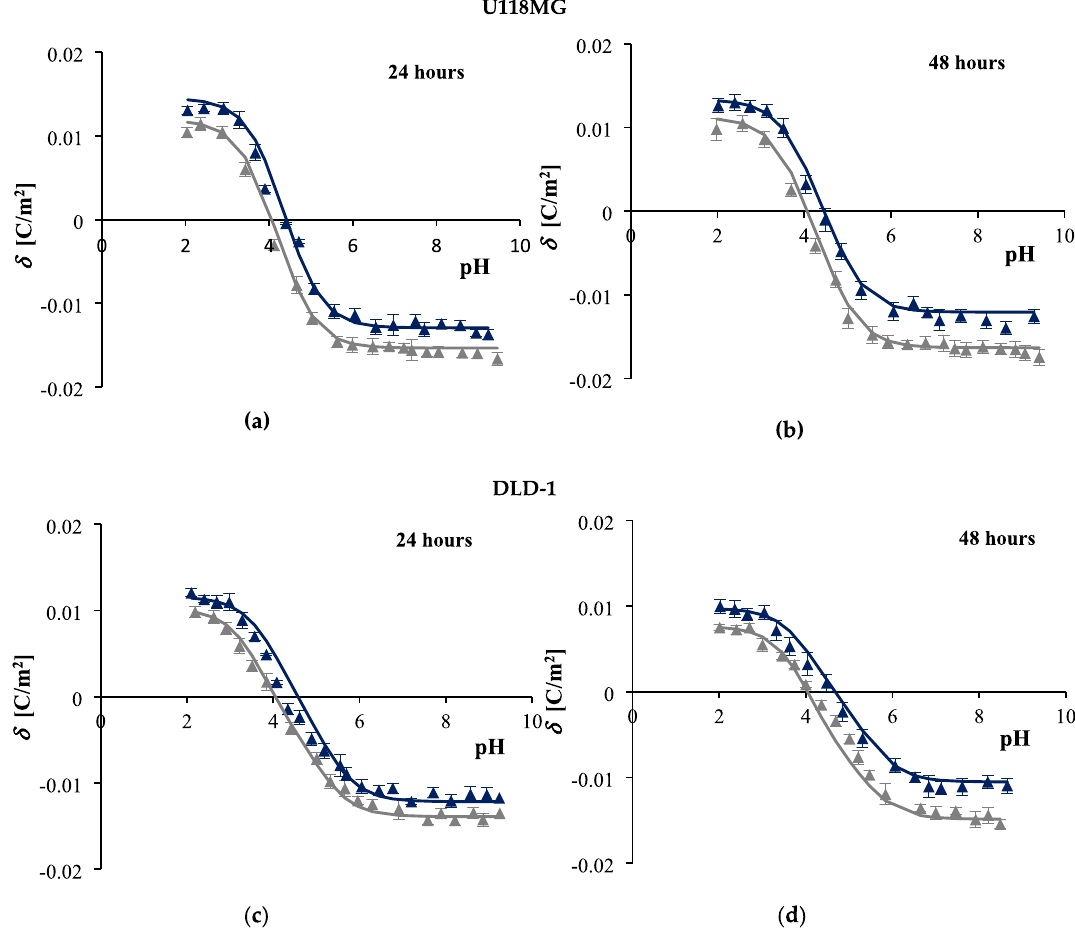
Figure 2. The membrane surface charge density of U118MG glioblastoma cells ( a , b ) and DLD-1 colon adenocarcinoma cells ( c , d ) at different pH values. Control cells are represented by grey and CA-treated cells by navy blue markings. Cells were treated for 24 h ( a , c ) and 48 h ( b , d